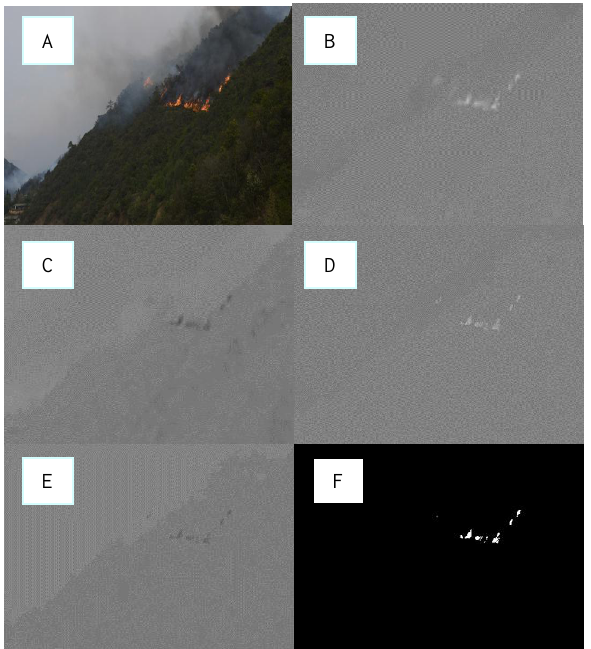
Figure 3 Color Space Conversion Based on YCrCb Color Model （ A: forest flame original image; B: Cr component; C: Cb component; D: K-means value after the Cr component; E: K -means value after the Cb component; F: Cr component binarization ）